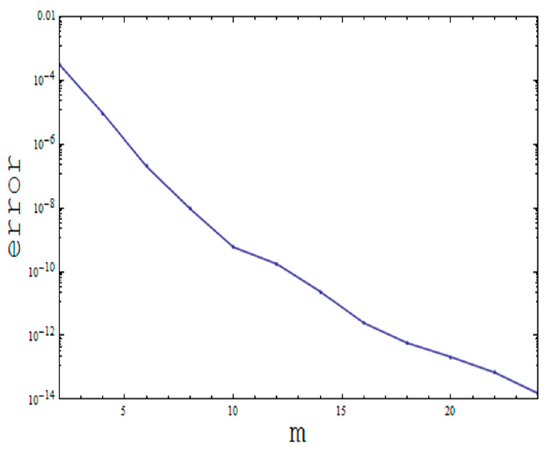
Figure 2. Results of 8th order approximations.